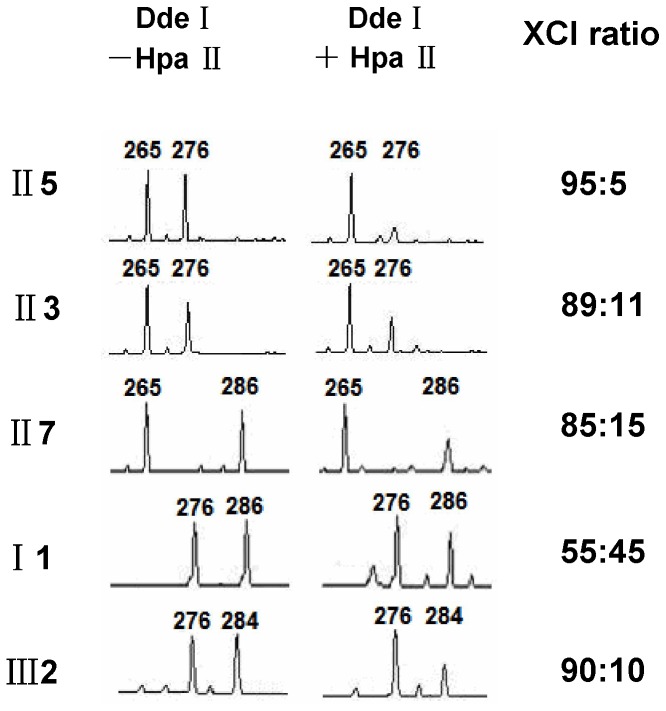
X chromosome inactivation analysis.After digestion with or without Hpa II, DNA was used to amplify a polymorphic CAG repeat within the androgen receptor (AR) gene. The size of the allele is determined by the number of repeats. The area under the peak indicates the degree of amplification of that allele. II5 and II3 inherited the allele 276 from their mother (I 1) and allele 265 from their father, II7 inherited the other allele 286 from I 1. After digestion with Hpa II, their paternal allele was predominantly amplified and represented the inactive. In contrast, III2 inherited the allele 276 from her mother (II3), which was predominantly amplified and represented the inactive. Thus four of them showed skewing of XCI (XCI ratio≥80∶20).